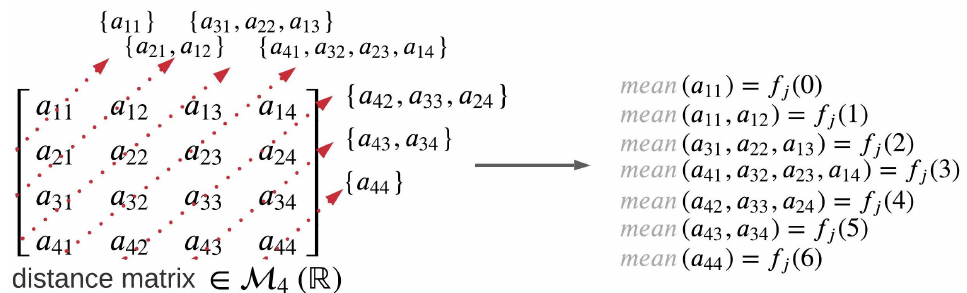
Figure 3. Visual explanation of cluster frontier extraction—phase